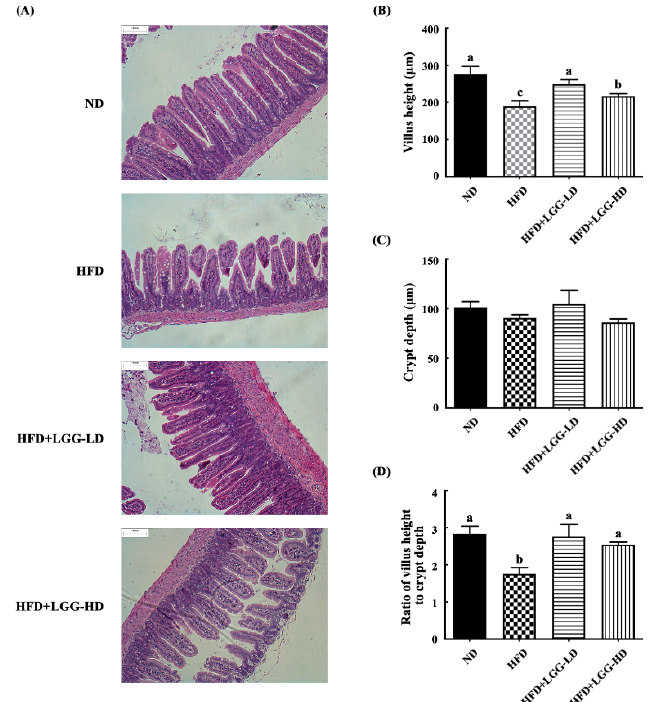
Figure 4. Effect of administration of Lactobacillus rhamnosus GG (LGG) on the histological morphology of the ileum in mice with diet-induced obesity. ( A ) Histological morphology of ileum. ( B ) Villus height. ( C ) Crypt depth. ( D ) Ratio of villus height to crypt depth. ND: normal diet; HFD: high-fat diet; HFD + LGG-LD: high-fat diet supplemented with low-dose LGG (10 8 CFU / mouse / day); HFD + LGG-HD: high-fat diet supplemented with high-dose LGG (10 10 CFU / mouse / day). a,b,c , Bars marked with different letters are significantly different at p < 0.05.